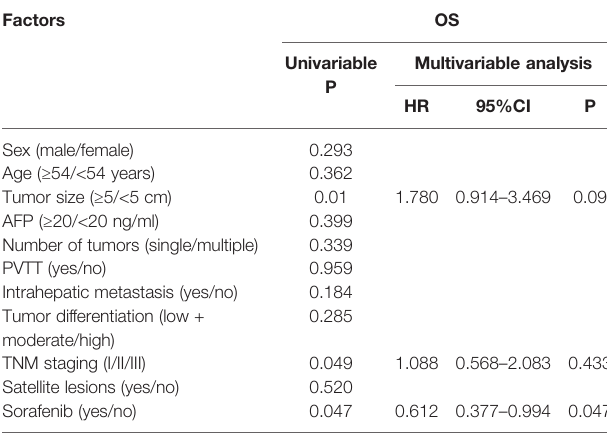
TABLE 2 | Univariable and multivariable analyses of survival in patients with HCC after radical resection in the PSM cohort.